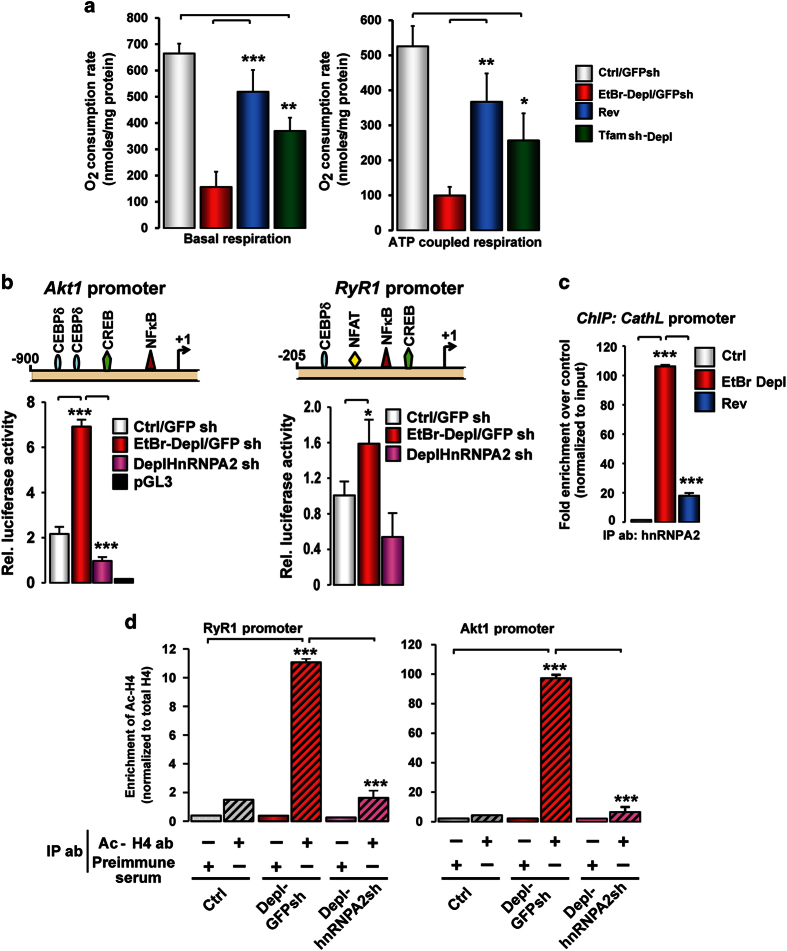
HnRNPA2-dependent histone H4 acetylation at stress-target gene promoters in
mtDNA-depleted cells. (a) Effects of PmtDNA depletion on cellular respiration.
(Left panel) Basal cellular respiration indicated as the oxygen consumption rate of
parental, PmtDNA-depleted (EtBr-treated or Tfam shRNA) C2C12 cells measured on
Seahorse XF24 analyzer using 50 000 cells per type. (Right panel) ATP-coupled and
maximal respiration measured by sequential addition of oligomycin
(2 μg ml−1), 3,5 dinitrophenol (DNP)
(75 μm) and rotenone (1 μm),
respectively. Data are represented as mean±s.d. (b) (Top panels) Cartoons of
the mitochondrial stress-responsive RyR1 and Akt1 promoter regions
depicting the putative mitochondrial stress-induced transcription factor binding sites
mapped using the MatInspector algorithm. (Bottom panels) Promoter luciferase activities
of stress-target genes, Akt1 and RyR1 after 48 h transfections
in control (parental C2C12 cells), PmtDNA-depleted/mock-shRNA and PmtDNA-depl/hnRNPA2sh
C2C12 cells. pGL3 basic vector was used as negative control. Renilla luciferase
activities were used for normalization of transfection efficiency. Data represent
mean±s.d. (c) ChIP assay showing association of hnRNPA2 at cathepsin L
promoter in control (parental C2C12 cells), PmtDNA-depleted and reverted C2C12 cells
using hnRNPA2 antibody. (d) ChIP assay of RyR1 and Akt1
promoters from control, PmtDNA-depl, and PmtDNA-depl/hnRNPA2sh cells immunoprecipitated
using an antibody to hyperacetylated histone H4. Data are represented as
mean±s.d.